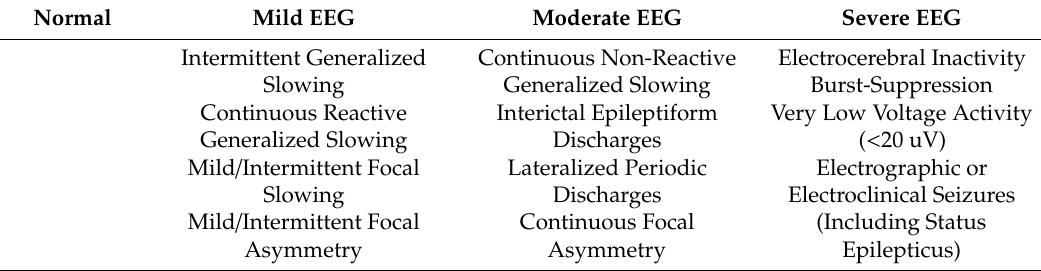
Table 2. Childhood EEG severity